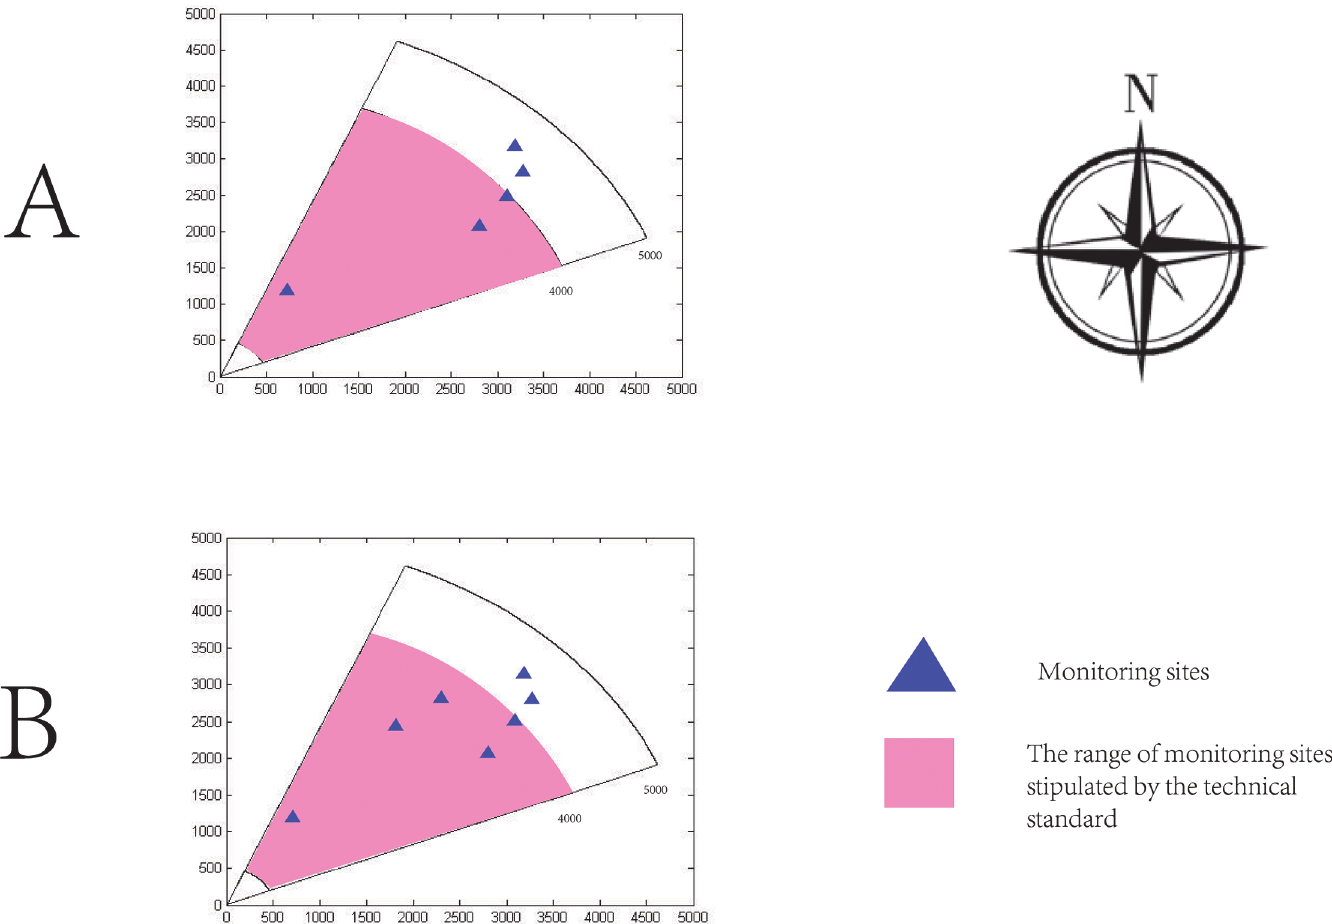
Fig 3. The positions of monitoring sites. (A) The actual positions of monitoring sites determined using fuzzy matter-element analysis. (B) The actual positions of monitoring sites that were improved using the hierarchical clustering method. The methods shown in (A) and (B) provide similar